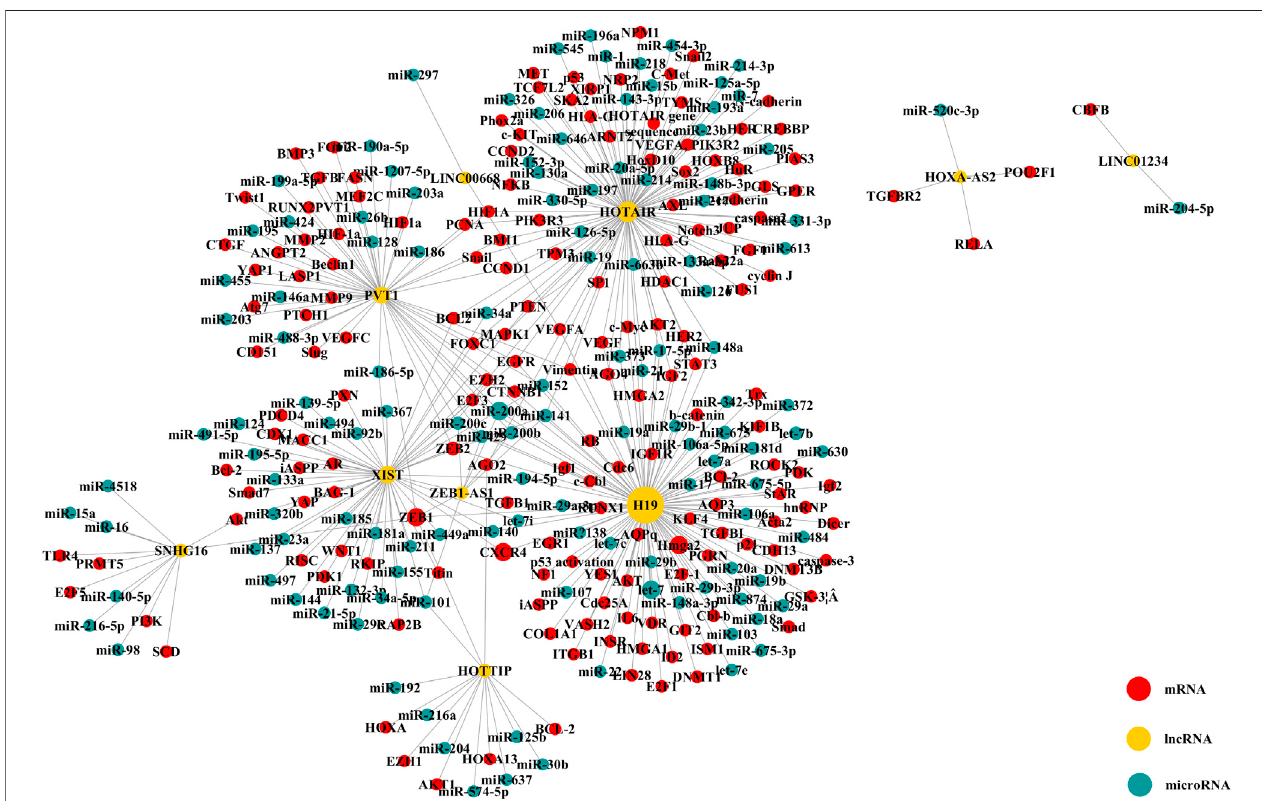
FIGURE 7 | ceRNA network of upregulated lncRNAs (The yellow node means lncRNA; the blue node, microRNA; and the red node, mRNA. The size of node changed with the degree).